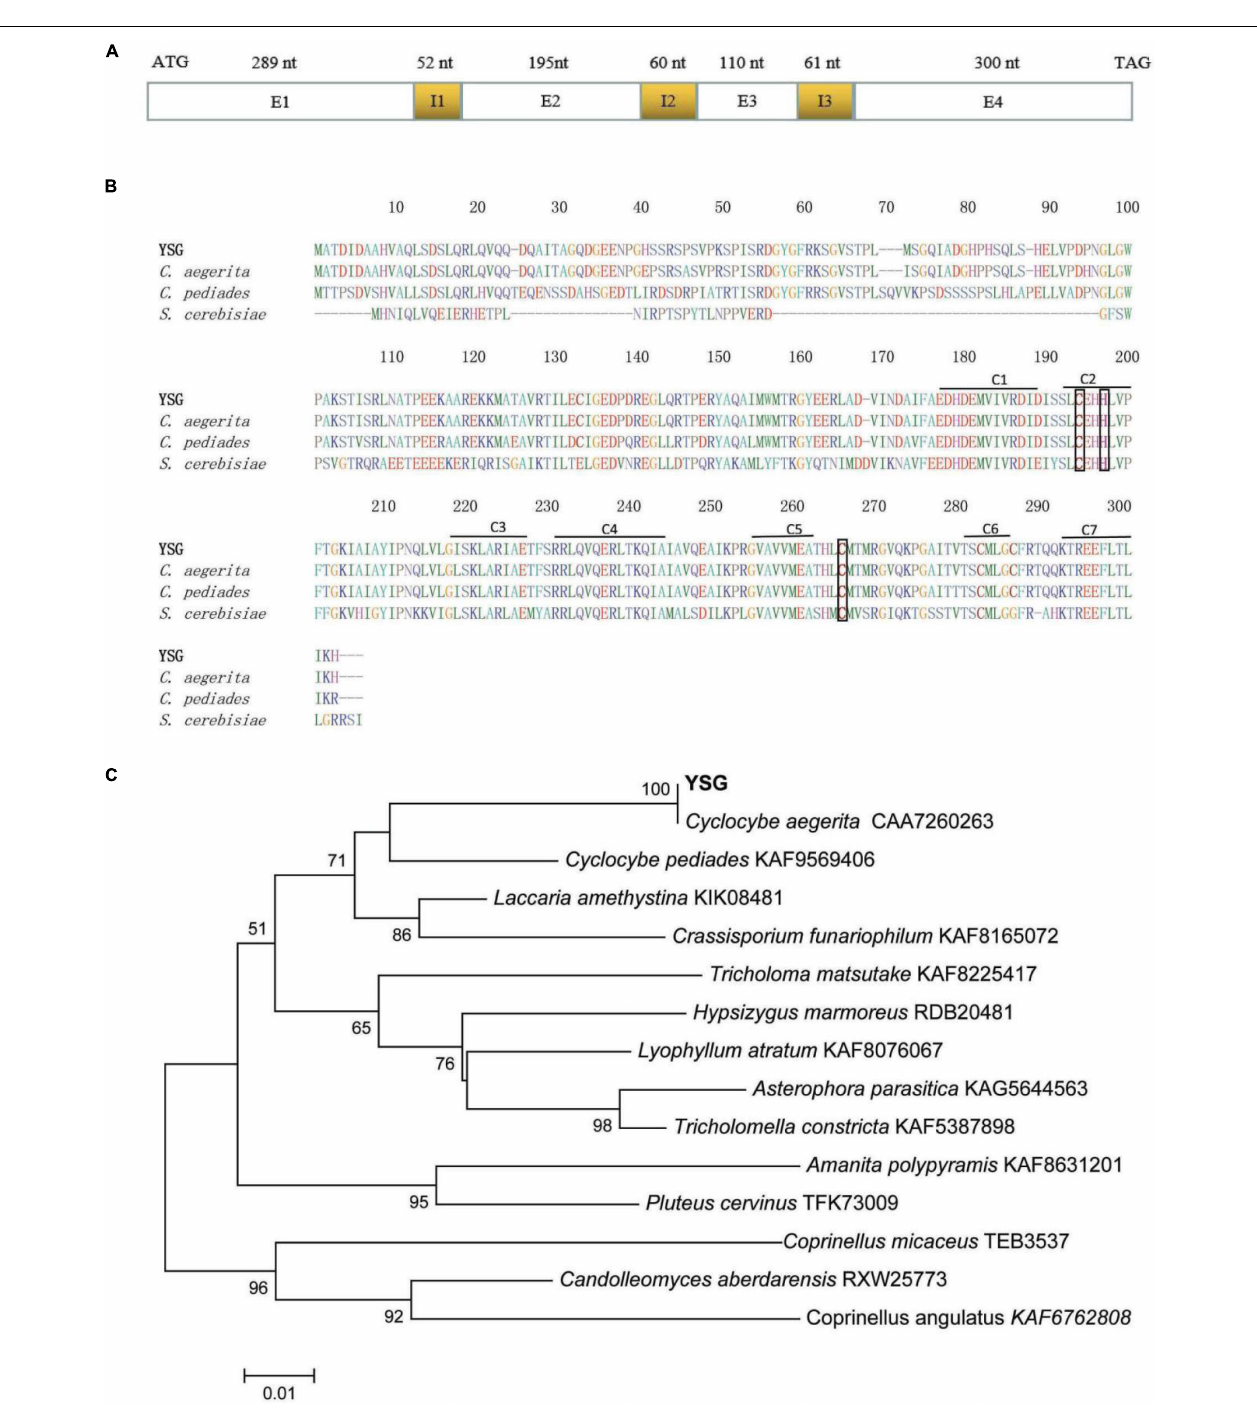
FIGURE 1 | (A) Sequence structure of cagch1 . (B) The characterization of the sequence of CaGCH1 (YSG) and its comparison with the sequences from other strains including C. aegerita (Accession Number CAA7260263), C. pediades (Accession Number KAF9569406), and S. cerevisiae (Accession Number P51601). (C) The phylogenetic tree for CaGCH1 with other GCH1 from basidiomycetes.